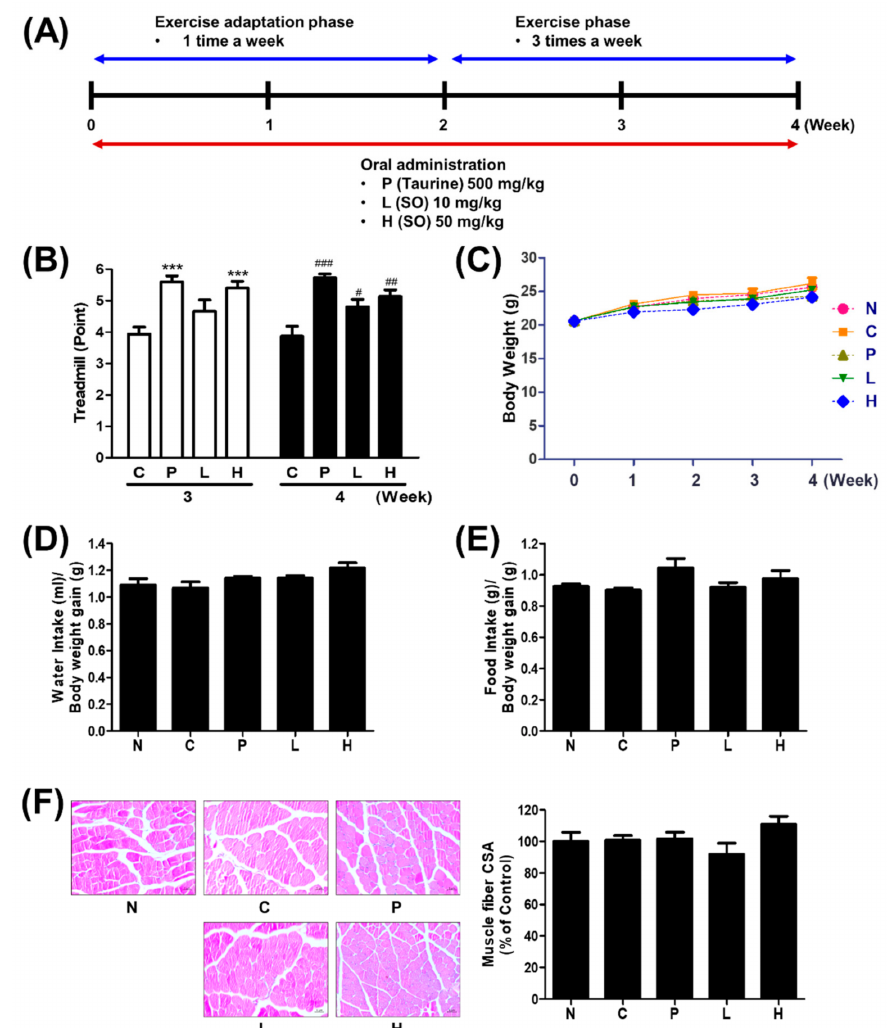
Figure 2. Administration of S. officinalis (SO) extract improved physical performance. ( A ) Scheme of treatment and physical activity schedule. ( B – D ) The endurance performance ( B ), body weight ( C ), water intake ( D ), and food intake ( E ) of each group were measured. ( F ) Representative H&E staining of the quadriceps muscle tissue. The results of ( B ) are shown as mean ± SEM. *** p < 0.001 compared with group C of 3 weeks. # p < 0.05, ## p < 0.01, and ### p < 0.001 compared with group C of 4